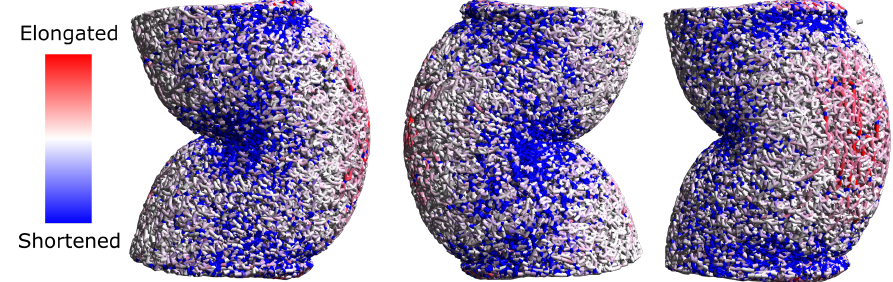
Figure 6. Residual deformation of aerogel